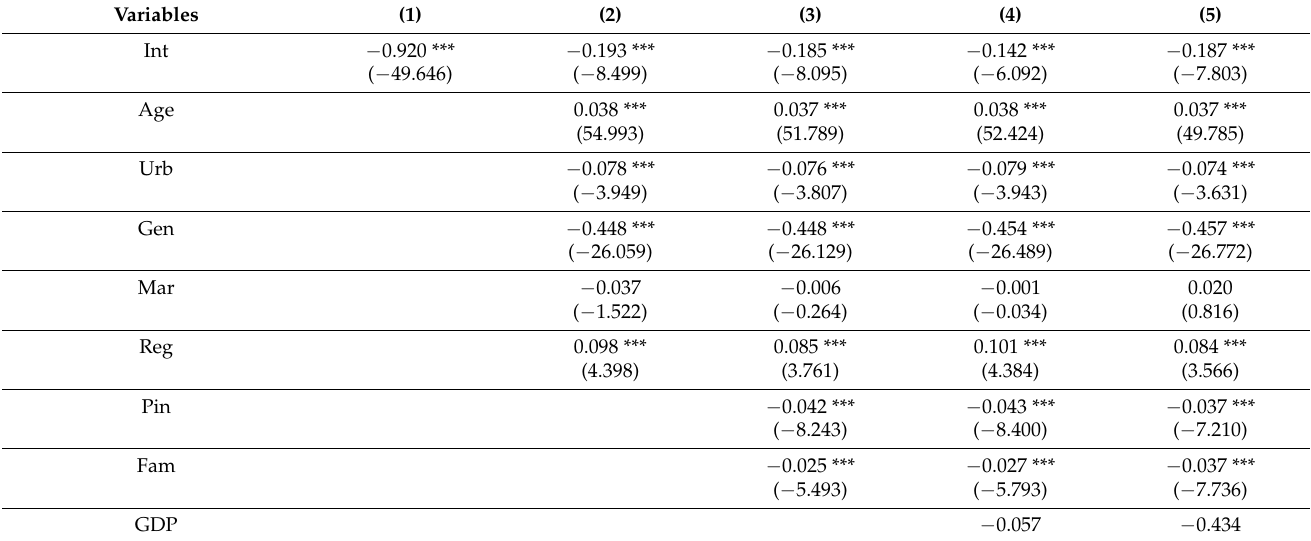
Table 2. Benchmark regression